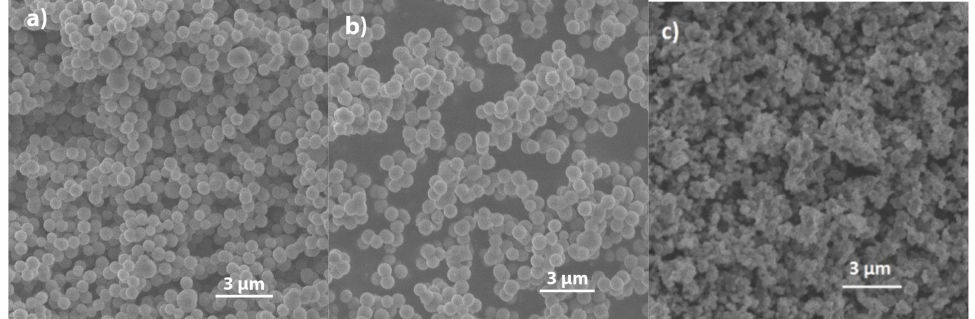
Figure 3. Scanning electron microscopy SiO 2 –C 3 H 6 -NH 2 : ( a ) NH 2 -0.5-0.2; ( b ) NH 2 -0.75-0.3; ( c ) NH 2 -1-0.4.